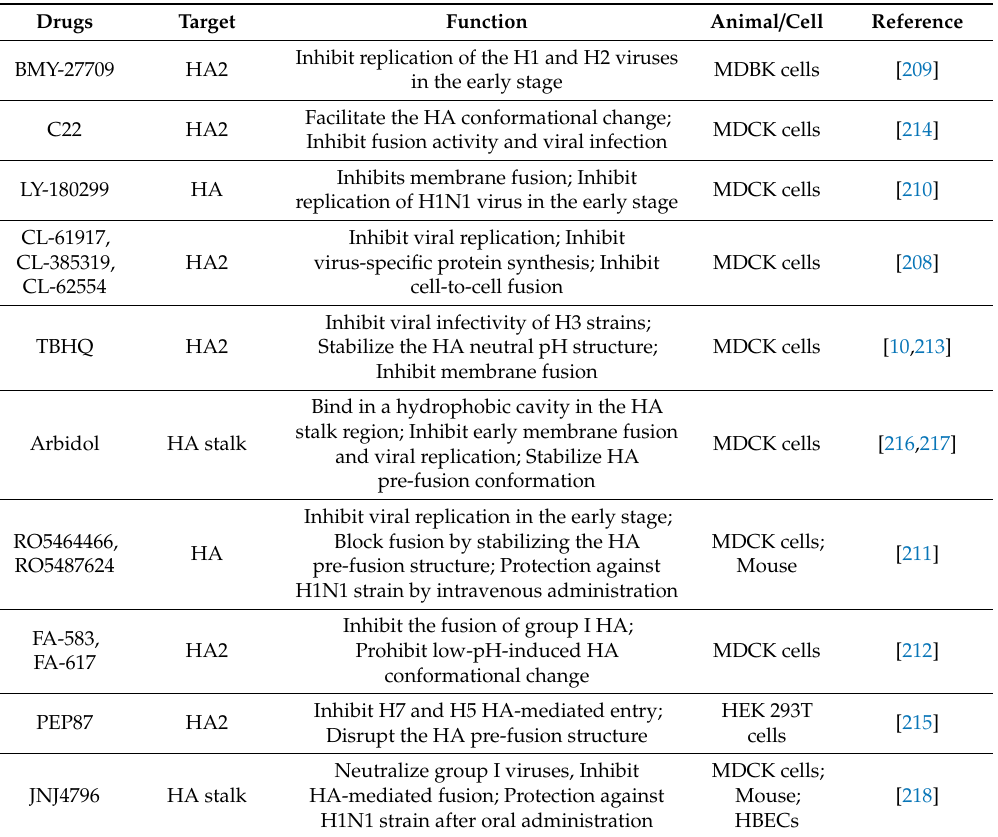
Table 2. The summary of anti-HA